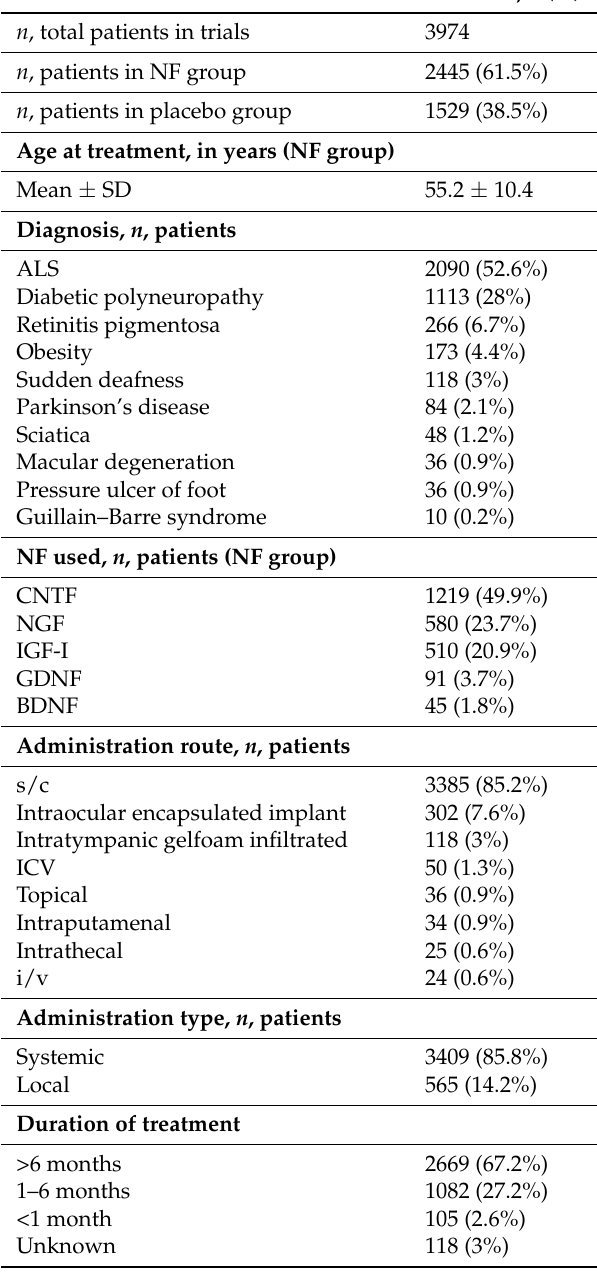
Table 4. Summary of patient characteristic and treatment modality in selected